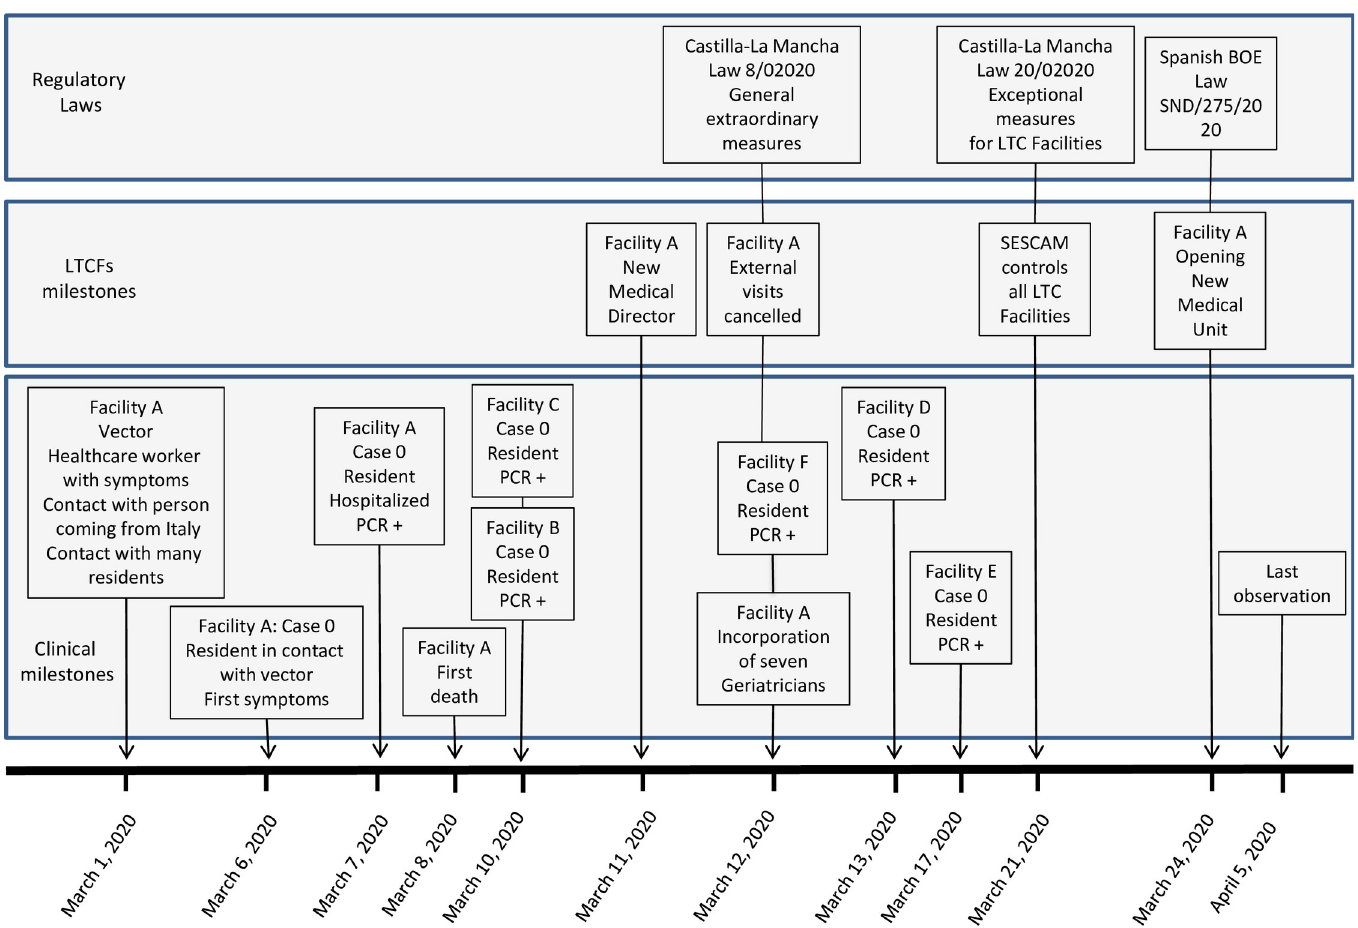
Fig 1. Timeline showing long-term care facilities outbreak in Albacete. PCR: Polymerase Chain Reaction. LTCF: Long-term care facilities. SESCAM: Healthcare Service of Castilla-La Mancha region. BOE: Boletı´n Oficial del Estado (Spanish Government bulletin for Laws).